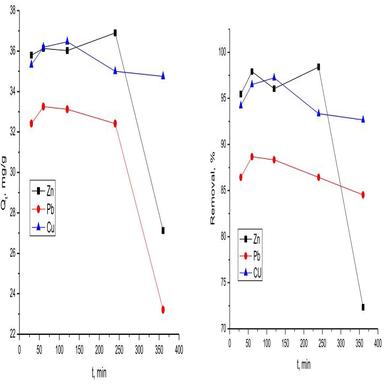
Effect of contact time on removal efficiency and removal capacity of heavy metals by SiO2@C nanocomposite (SC1).